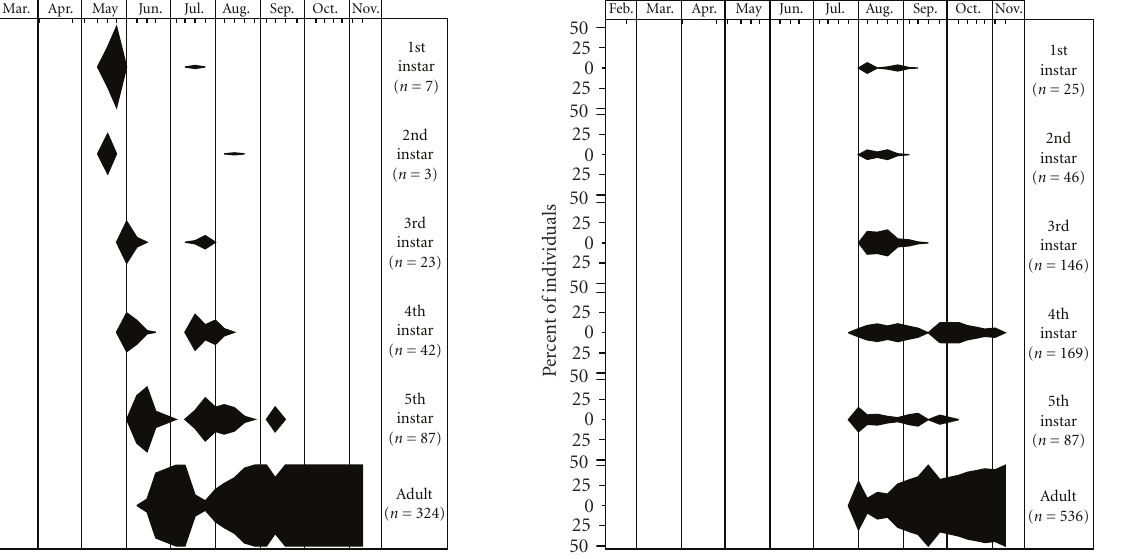
Figure 3: Percent of individuals of Rhagovelia oriander in each stage on each sample date.